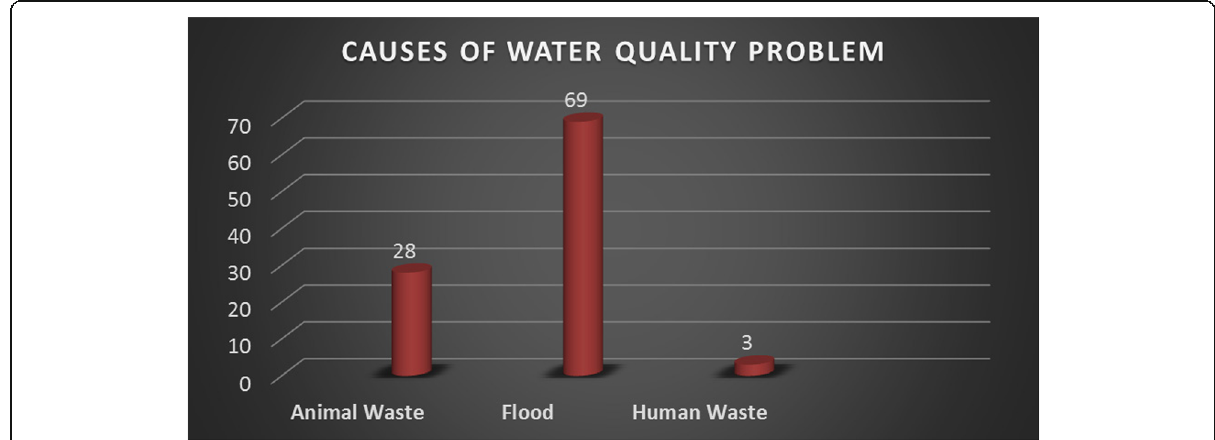
Fig. 2 Factors perceived to be the key causes of water contamination at household level